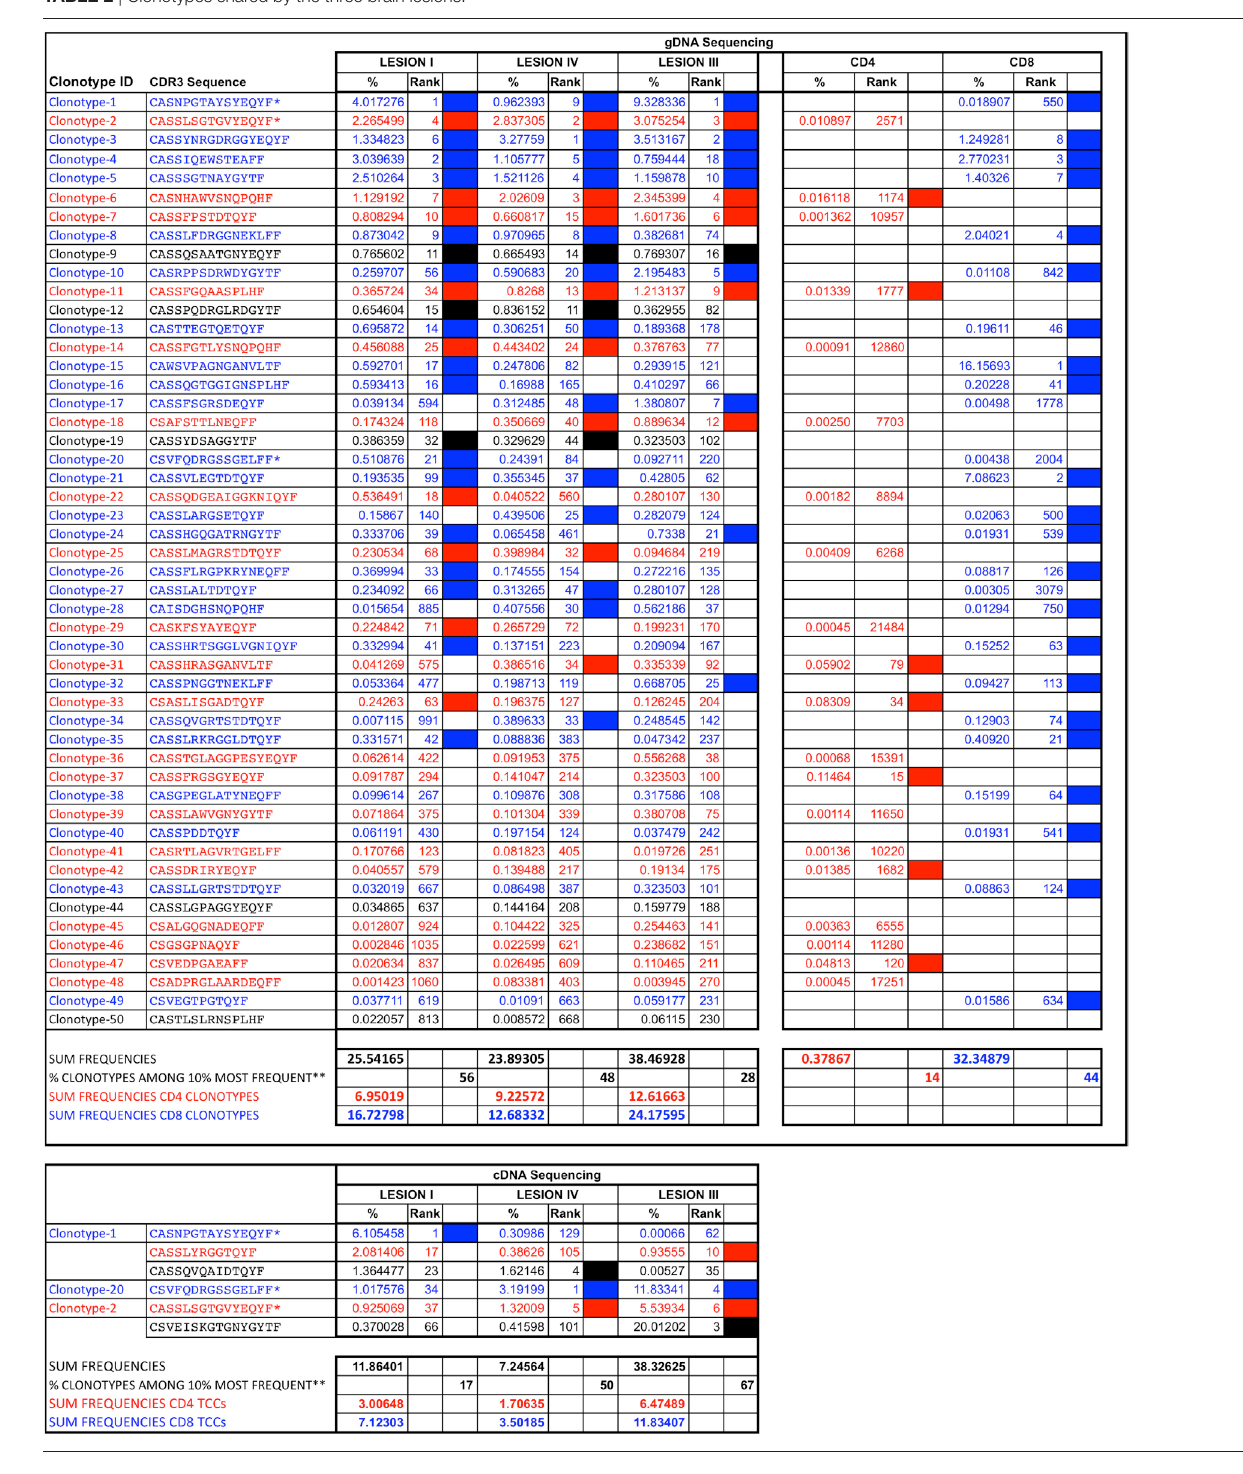
TaBle 2 | Clonotypes shared by the three brain